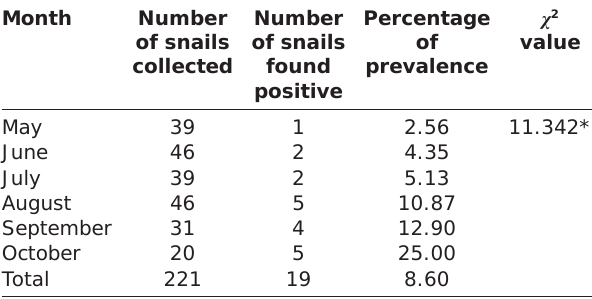
Table-2: Overall month-wise prevalence of Indoplanorbis spp. having infective stages of parasites in and around Ranchi.